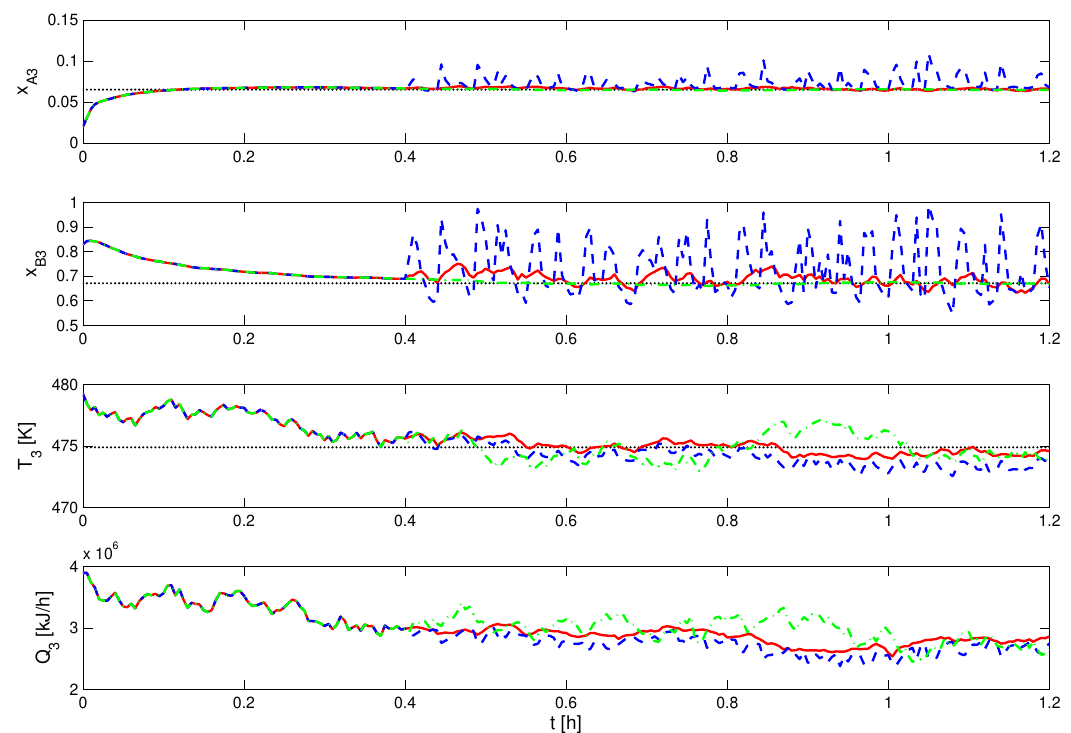
Figure 4. States and input trajectories of subsystem 3 given by the proposed distributed MHE-LMPC (solid line), scheme II (dash-dotted line) and scheme III (dashed line). The set points of states are denoted as dotted line.